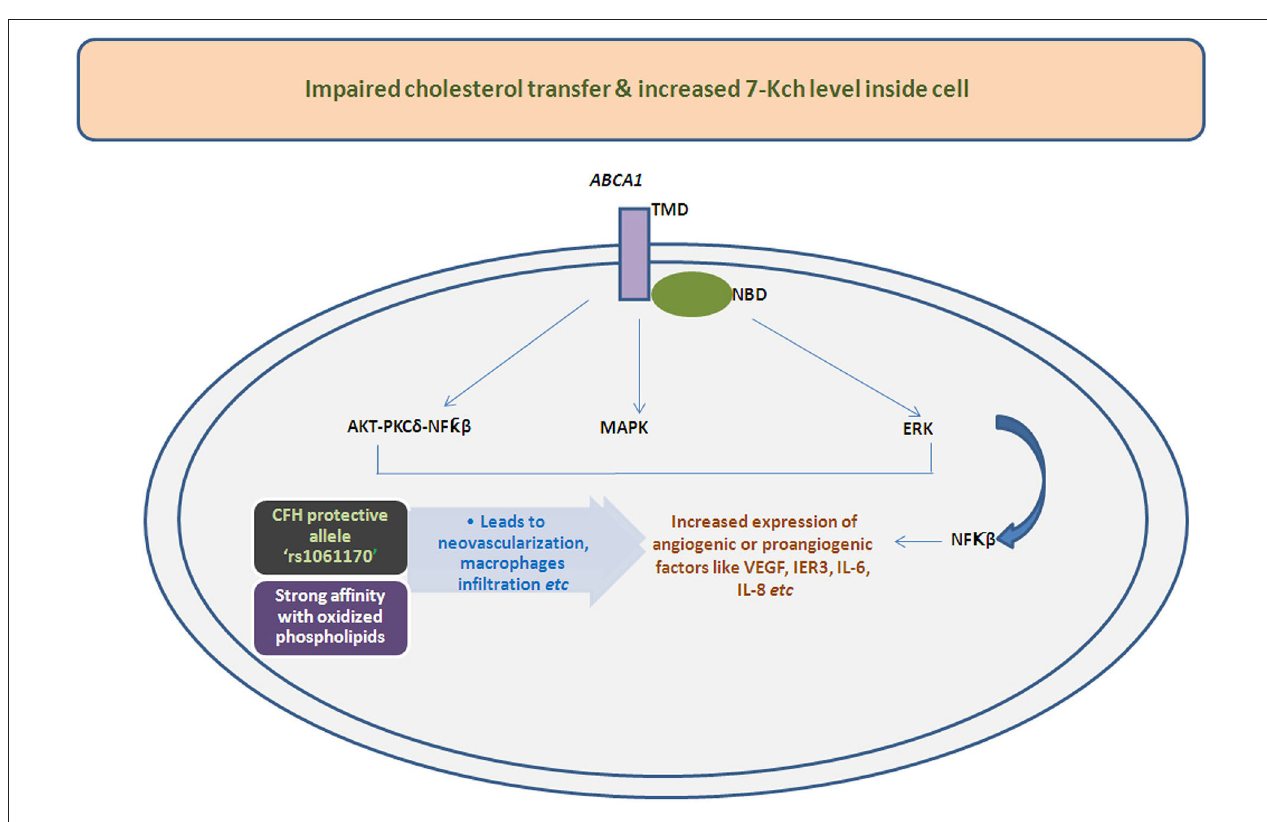
hampered action of ABCA1 transporter . The deposited oxidized cholesterols components also have shown higher affinity with protective allele of CFH i.e., rs1061170 which can also changes the expression of angiogenic